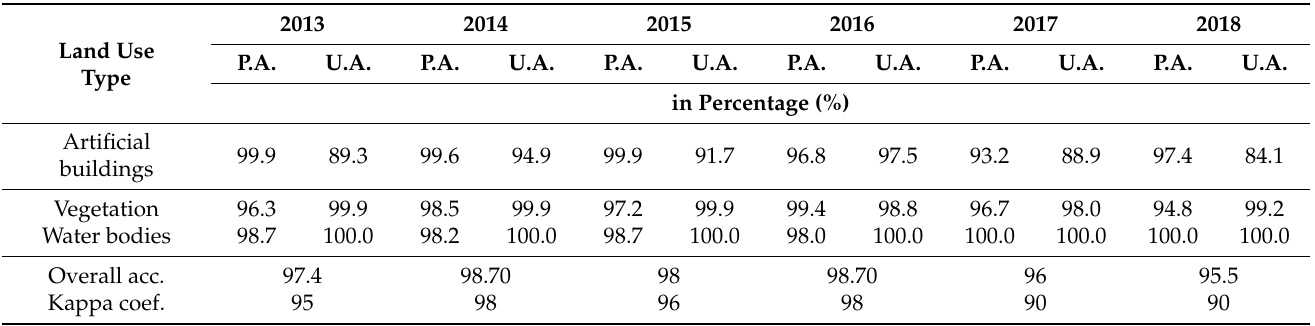
Figure 7. Land cover distribution area and their changes during 2013–2018. Table 2. Accuracy of satellite image land cover classification. P.A. and U.A. represent the producer and user accuracies,